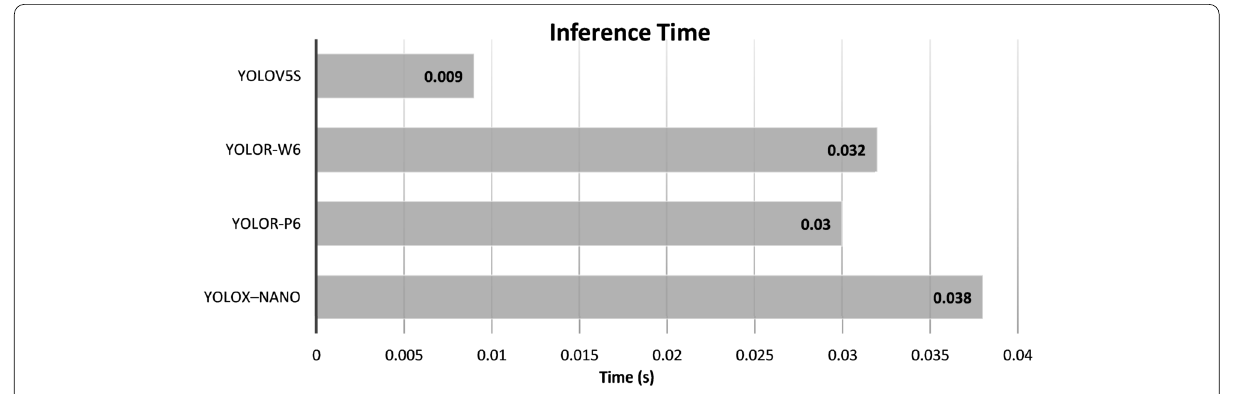
Figure 12 Comparison of inference speed of the different model. YOLOv5s has the lowest